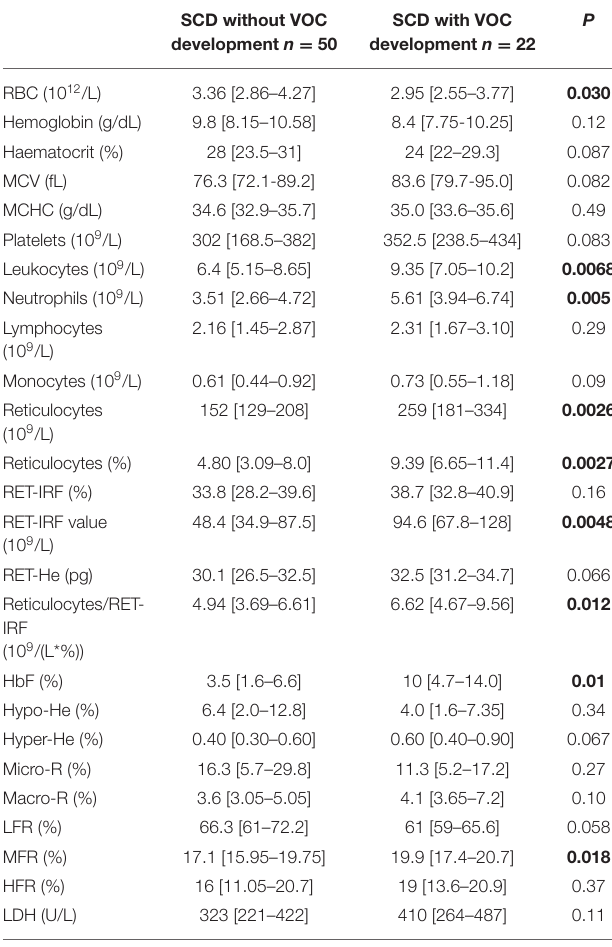
TABLE 2 | Reticulocyte and erythrocyte parameter comparison between steady state vs. VOC. Parameters